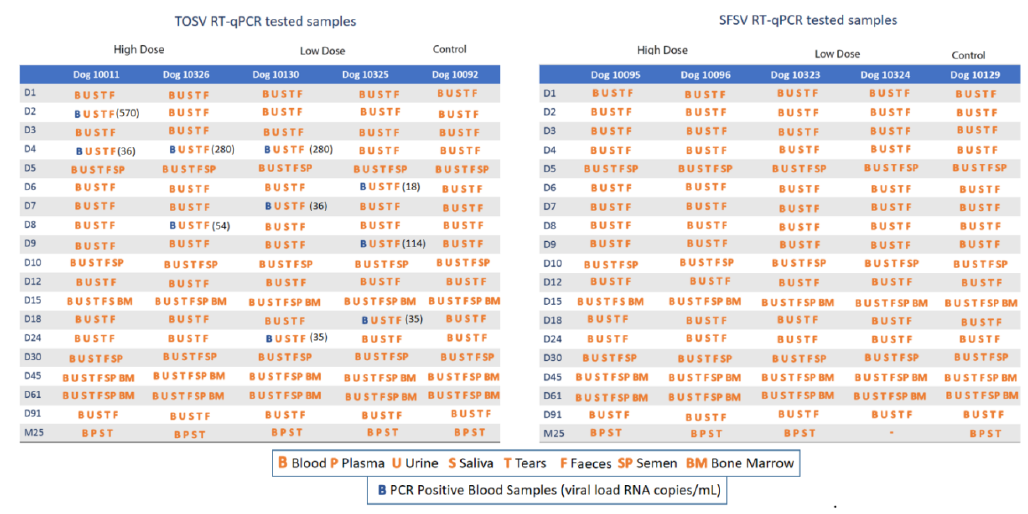
Figure 2. Sequential sampling and viral loads in TOSV- and SFSV-inoculated dogs.